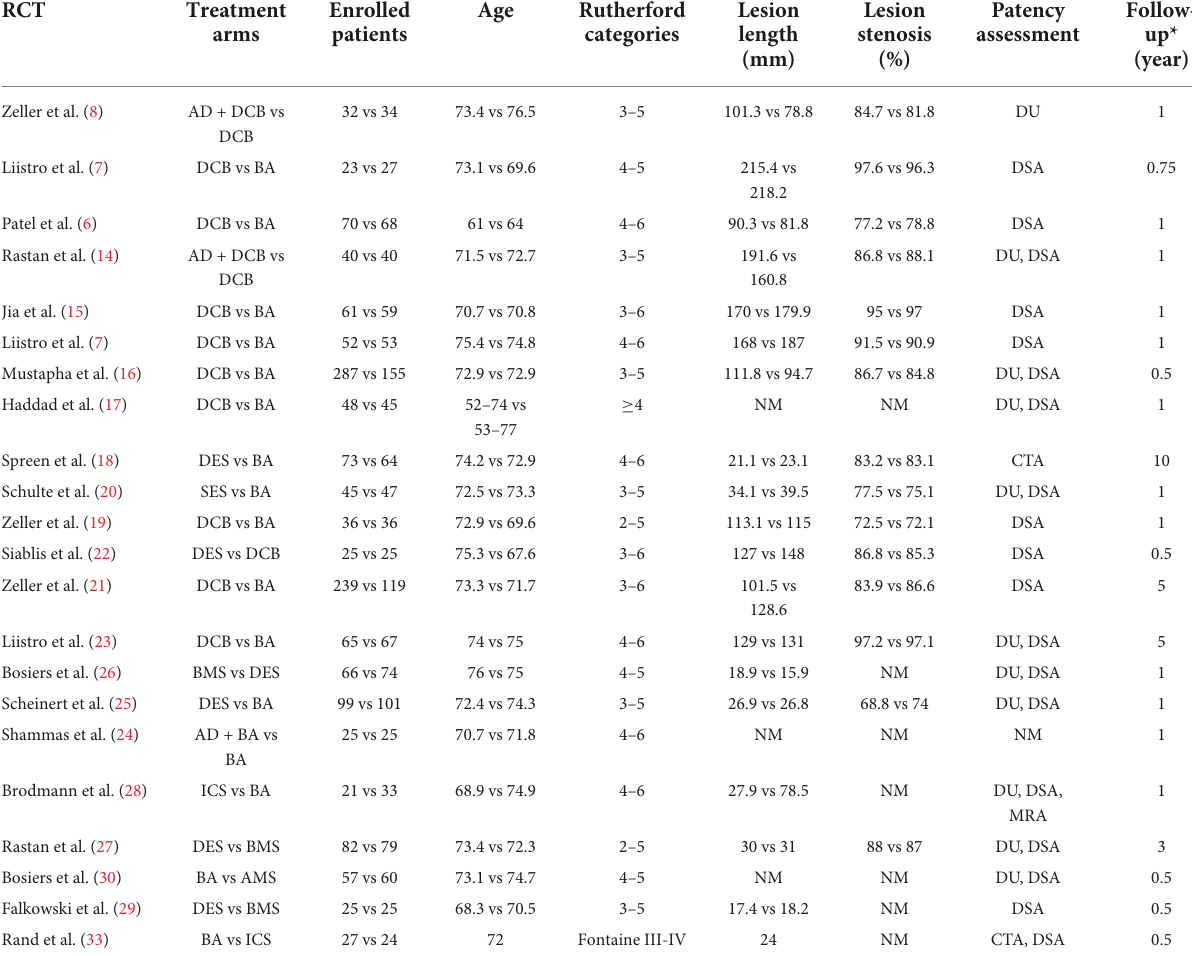
TABLE 1 Characteristics of the eligible randomized controlled trials (RCT) included in the network meta-analysis.